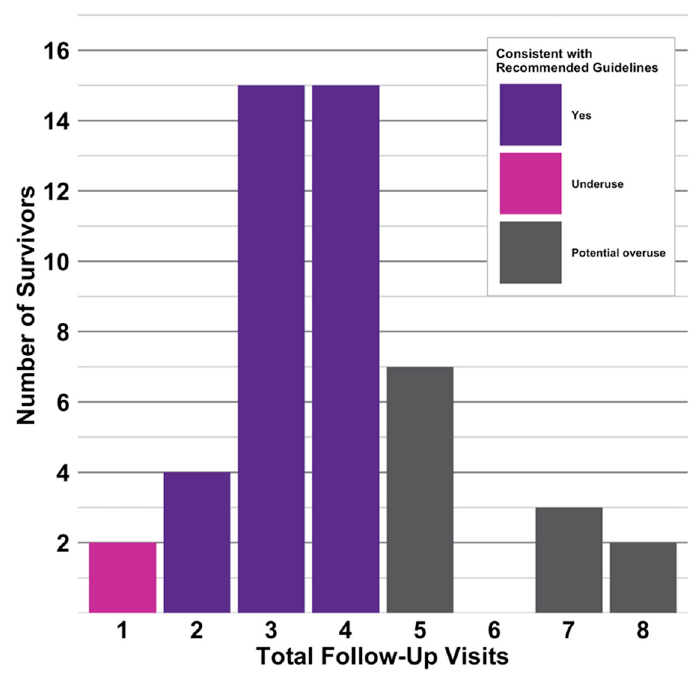
Figure 3. Frequency of follow-up visits in the study population ( n = 48) in the first year of follow-up (360 days). The colour of the columns indicates whether the number of visits was consistent with the ACS survivorship care guidelines [8]. ACS: American Cancer Society.